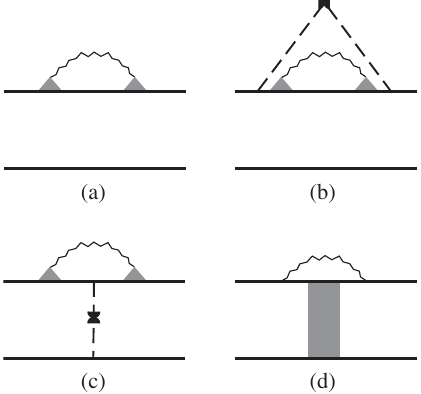
FIG. 4. The dominant Fock-type self-energy corrections to L ð ω ; q Þ , as described in Refs. [52,53]. Each diagram has a partner diagram generated by reflecting about the horizontal axis. Hartree-type contributions are not shown; they are suppressed for sufficiently long-range interactions.